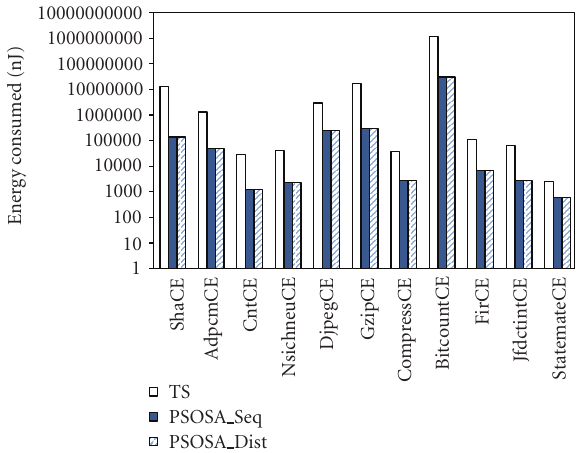
Figure 3: Energy consumed by benchmarks studied in this work.